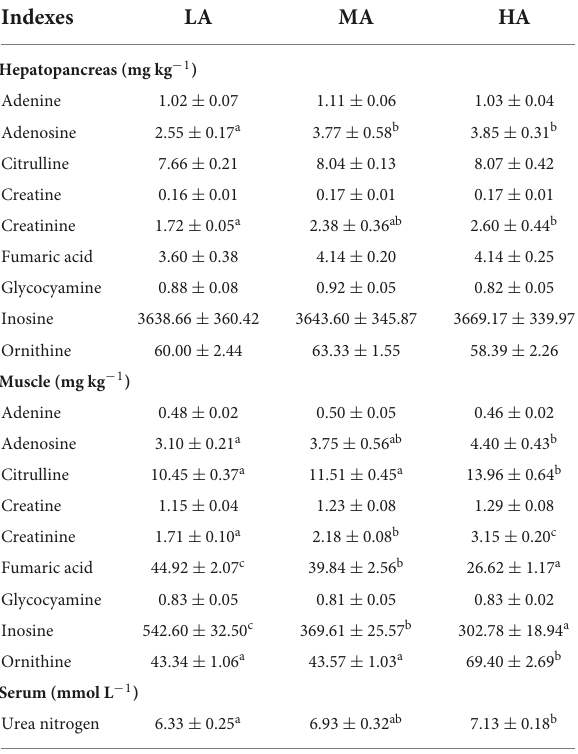
TABLE 4 Relative metabolites of arginine contents in the hepatopancreas, muscle, and serum of L. vannamei after dietary arginine